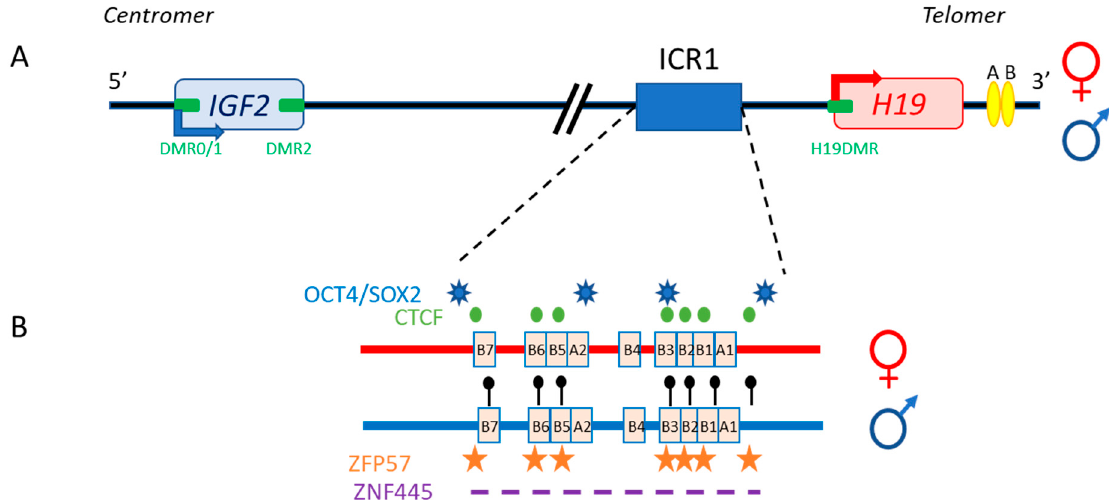
Figure 2. The human IGF2/H19 11p15.5 locus. ( A ) The IGF2 and H19 genes are separated by about 80 kb. IGF2 is paternally expressed (blue arrow), whereas H19 is maternally expressed (red arrow). The four DMR (green boxes) and enhancers (yellow ellipses) are represented. ( B ) H19/IGF2 :IG-DMR (ICR1) in detail: OCT4/SOX2 (blue stars) and CTCF (green circles) binding sites on the maternal allele (red), and methylation sites (black lollipops), ZFP57 binding sites (orange stars) and the undefined ZNF445 binding site consensus sequence (purple dash) on the paternal allele (blue) are shown. Nomenclature: IGF-II (IGF-I, IGF-1R, etc.) is used for the protein in humans, and Igf-II (Igf- I, Igf1r, etc.) is used in other species. IGF2 (IGF1 , IGF1R , etc .) is used for the gene in humans, and Igf2 ( Igf1 , Igf1r , etc.) is used in other species.